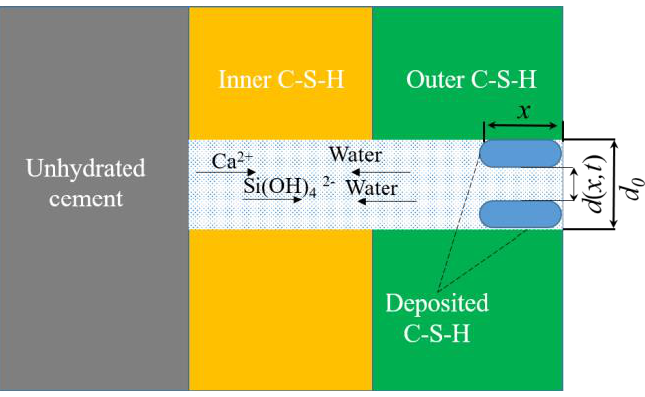
Figure 1. The deposition of CSH during the diffusion period of cement hydration.